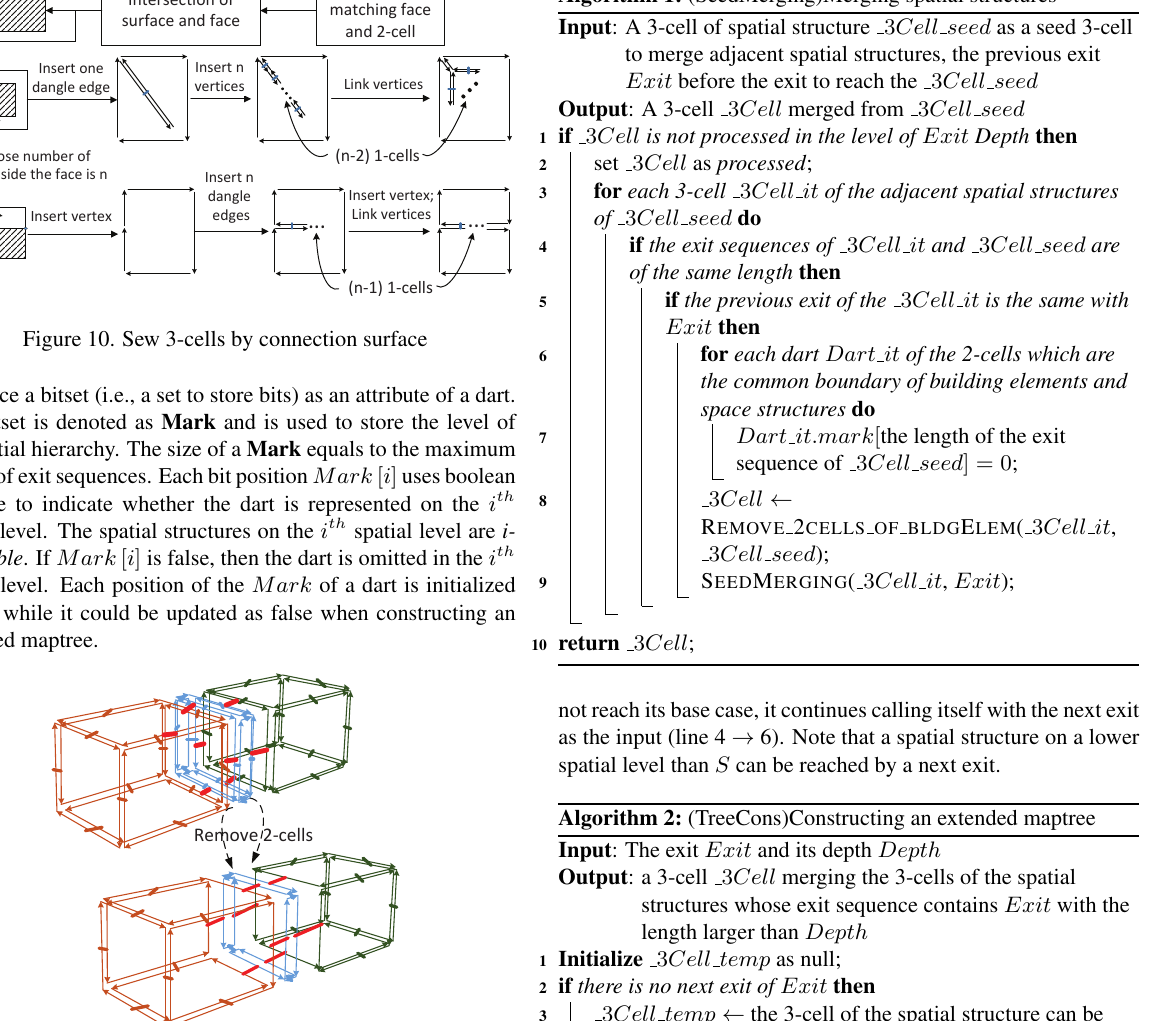
Algorithm 1: (SeedMerging)Merging spatial structures